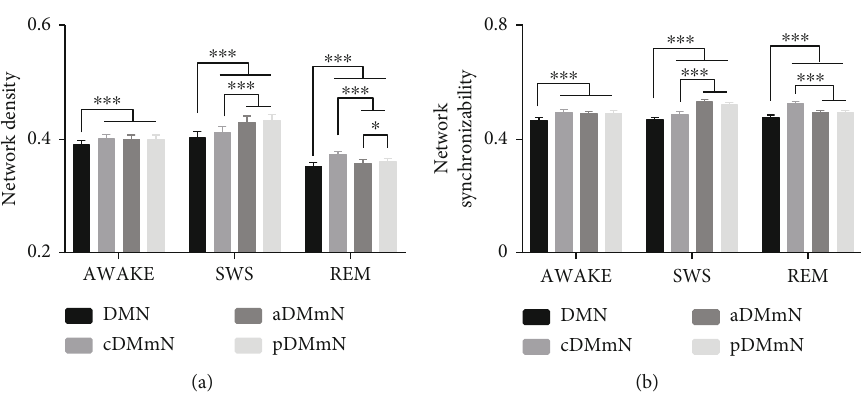
Figure 4: The network density of FC and network synchronizability of the three CAMP networks and the DMN in each state of consciousness. (a) Comparisons of network density. (b) Comparisons of network synchronizability. ∗ indicates a signi fi cant di ff erence with p < 0 : 05 . ∗∗ indicates a very signi fi cant di ff erence with p < 0 : 01 . ∗∗∗ indicates the most signi fi cant di ff erence with p < 0 : 001 .